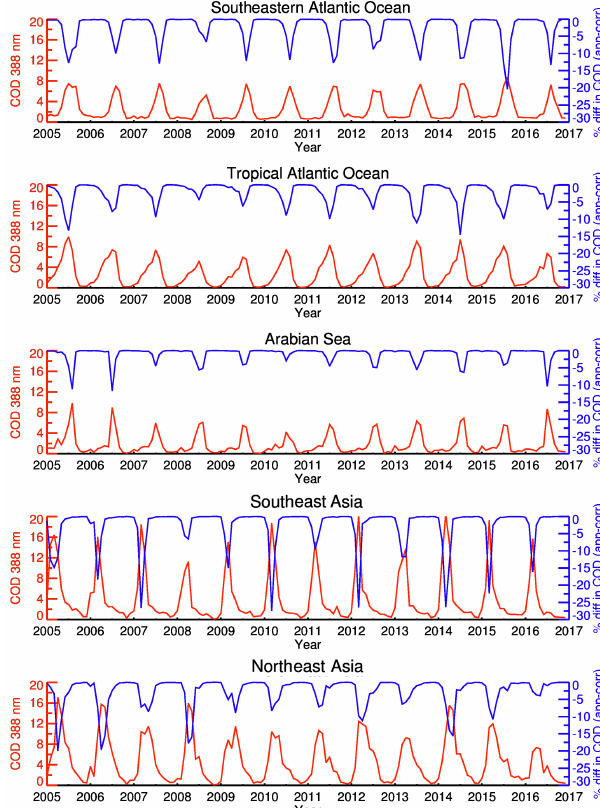
Figure 10. Time series of regional, monthly mean aerosol-corrected (left y axis, color: red) COD (388nm) derived using a 12-year long OMACA record. The y axis on the right side (color: blue) depicts a time series of the % difference between simultaneous retrievals of apparent/non-corrected and aerosol-corrected COD for the same period and regions. Only anomaly-free observations of OMI (Rows 1 to 23) were used in the